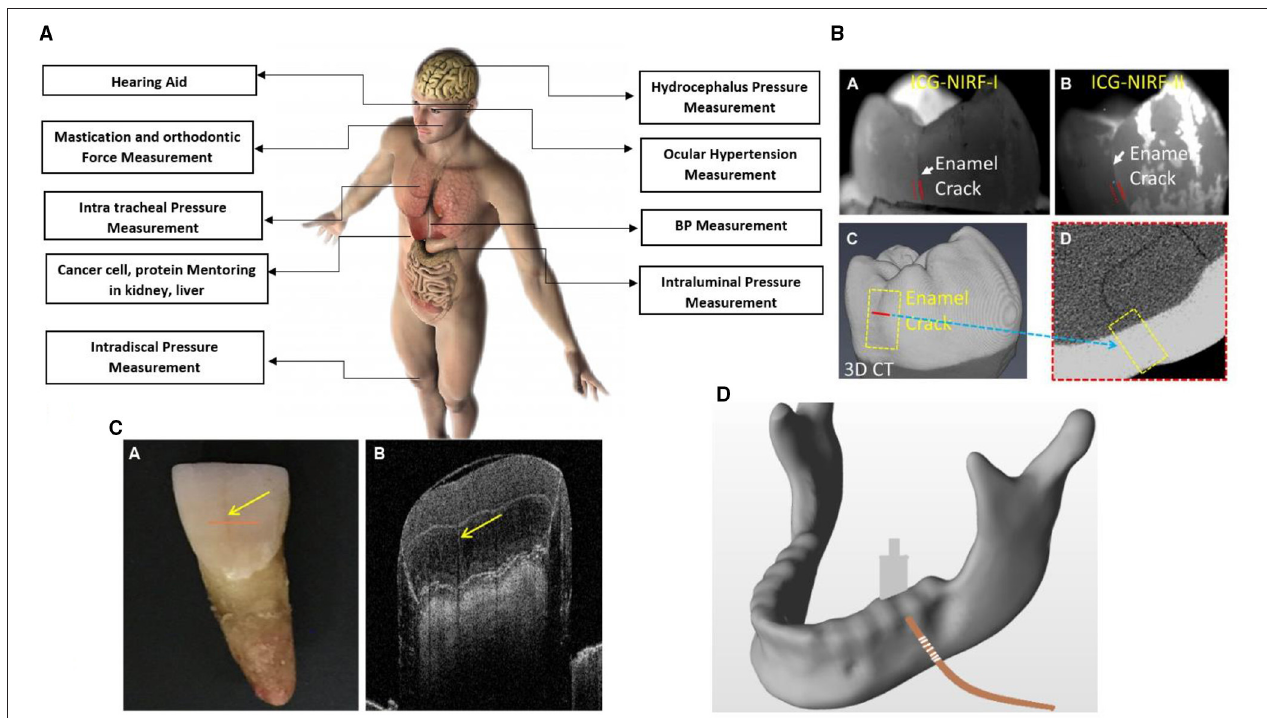
FIGURE 8 | (A) Optical MEMS sensors application in the human body (50). (B) Dental X-Ray imaging of cracks by green near infrared imaging (51). (C) Dental OCT imaging ( 53). (D) FBG integration with human mandibular